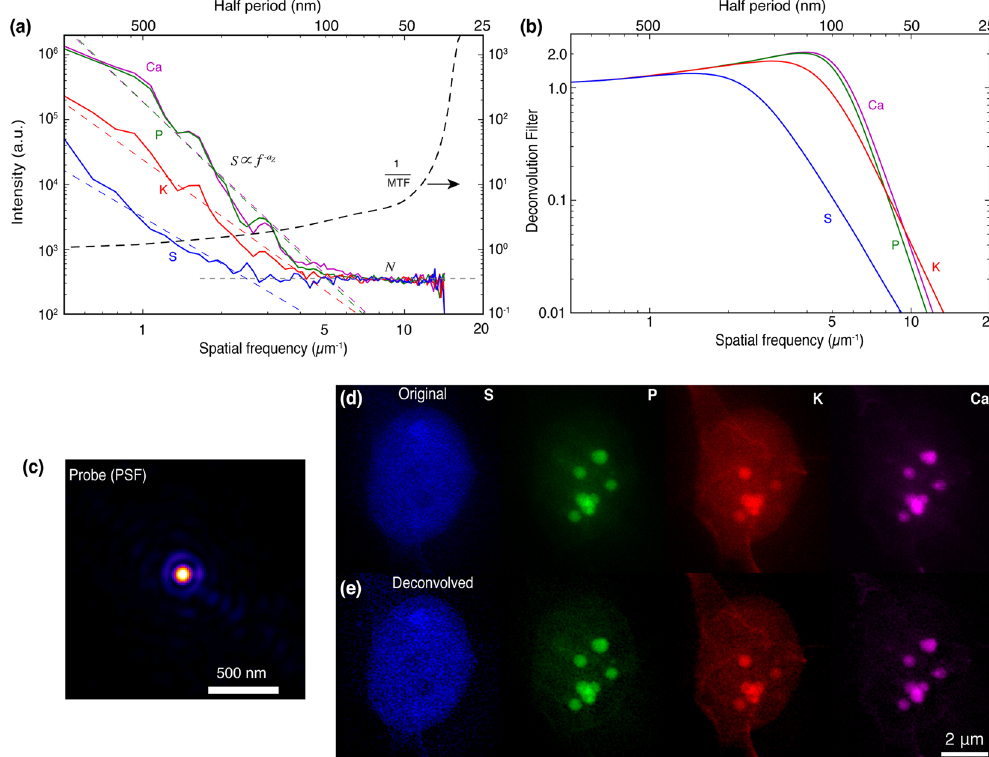
Figure 4. Deconvolution of fluorescence images using the reconstructed x-ray probe provided by ptychography and modified deconvolution filters. ( a ) Power spectra of Ca, P, K, S fluorescence images shown along with their respective signal trends ∝ − S f a Z , and the half-period length scales x cutoff marking the transition to a noise floor N . Also shown is the azimuthally-averaged inverse modulation transfer function 1/MTF( f ) that one would use as a Fourier deconvolution filter with a noise-free image (Eq. 2). ( b ) The deconvolution filters D Z ( f ) for the elements Z = Ca, P, K, and S obtained using Eq. 4. ( c ) The intensity point spread function (PSF) of the in ( b ). The fluorescence maps i ( x , y ) before deconvolution are shown in ( d ) (these are the same images as shown in Fig. 2(a)), and the deconvolved images o ( x , y ) are shown in ( e ). The deconvolved images show improved detail, and a reduction of a poorly-spatially-resolved fluorescence “haze” on the